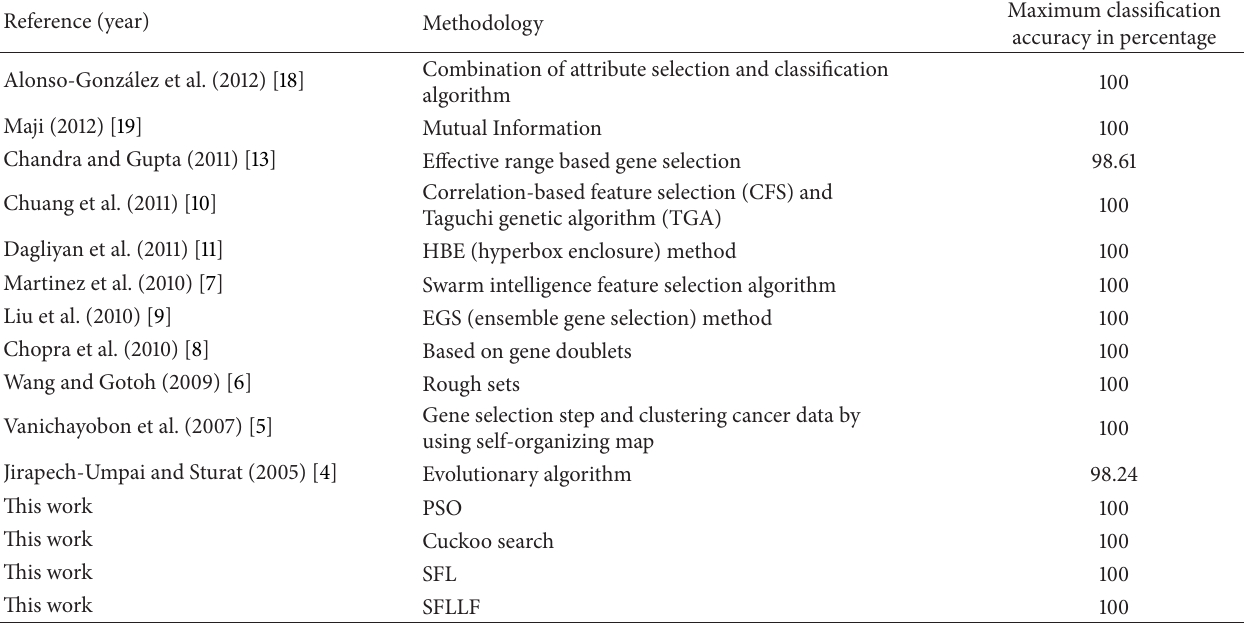
Table 10: Comparison of classification accuracy with other methods for AML-ALL.